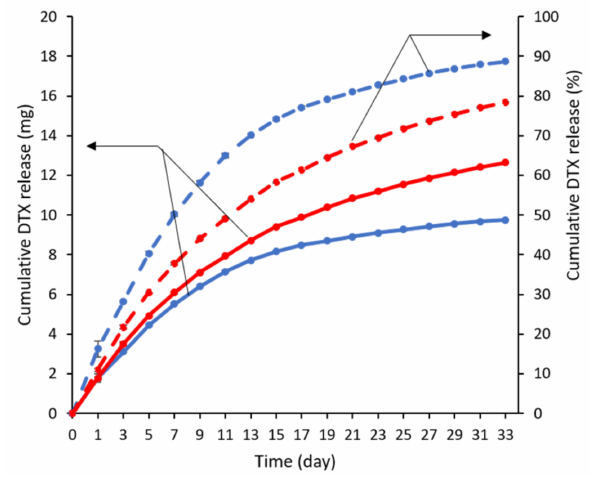
Figure 3. In vitro release profiles of DTX from 1.92 (blue) and 2.79% w / w (red) DTX-loaded stents over 33 d, conducted in PBS at pH 6.5 and containing 0.1% v / v Tween 80 ( n = 3). Solid and dashed lines represent the cumulative DTX release in mg and percentage, respectively. Error bars are smaller than symbols.